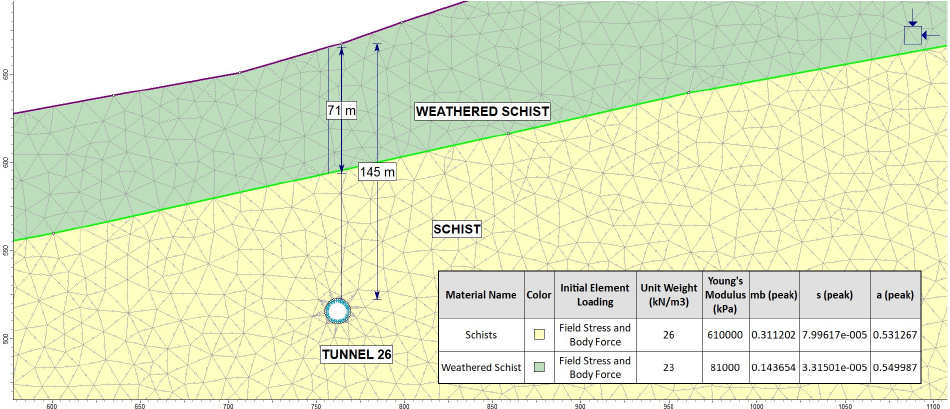
Figure 18. The geological cross-section used in 2D numerical analysis and the material